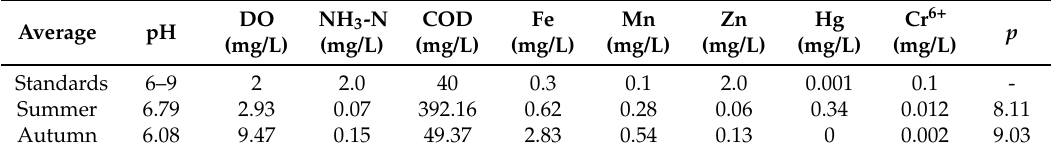
Table 2. The concentration of water quality parameters and comprehensive indexes for riverine